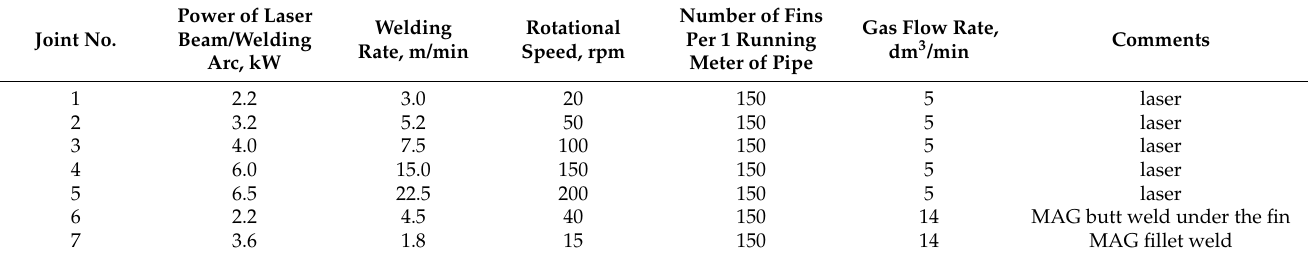
Table 1. Technological parameters of the laser welding of finned tubes and MAG-welded methods tubes.